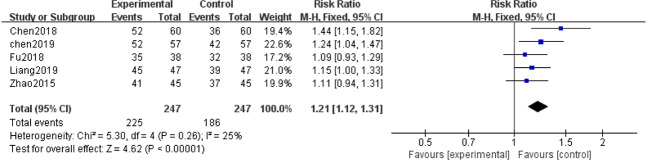
Forest plot for clinical efficacy between the treatment group and control group.